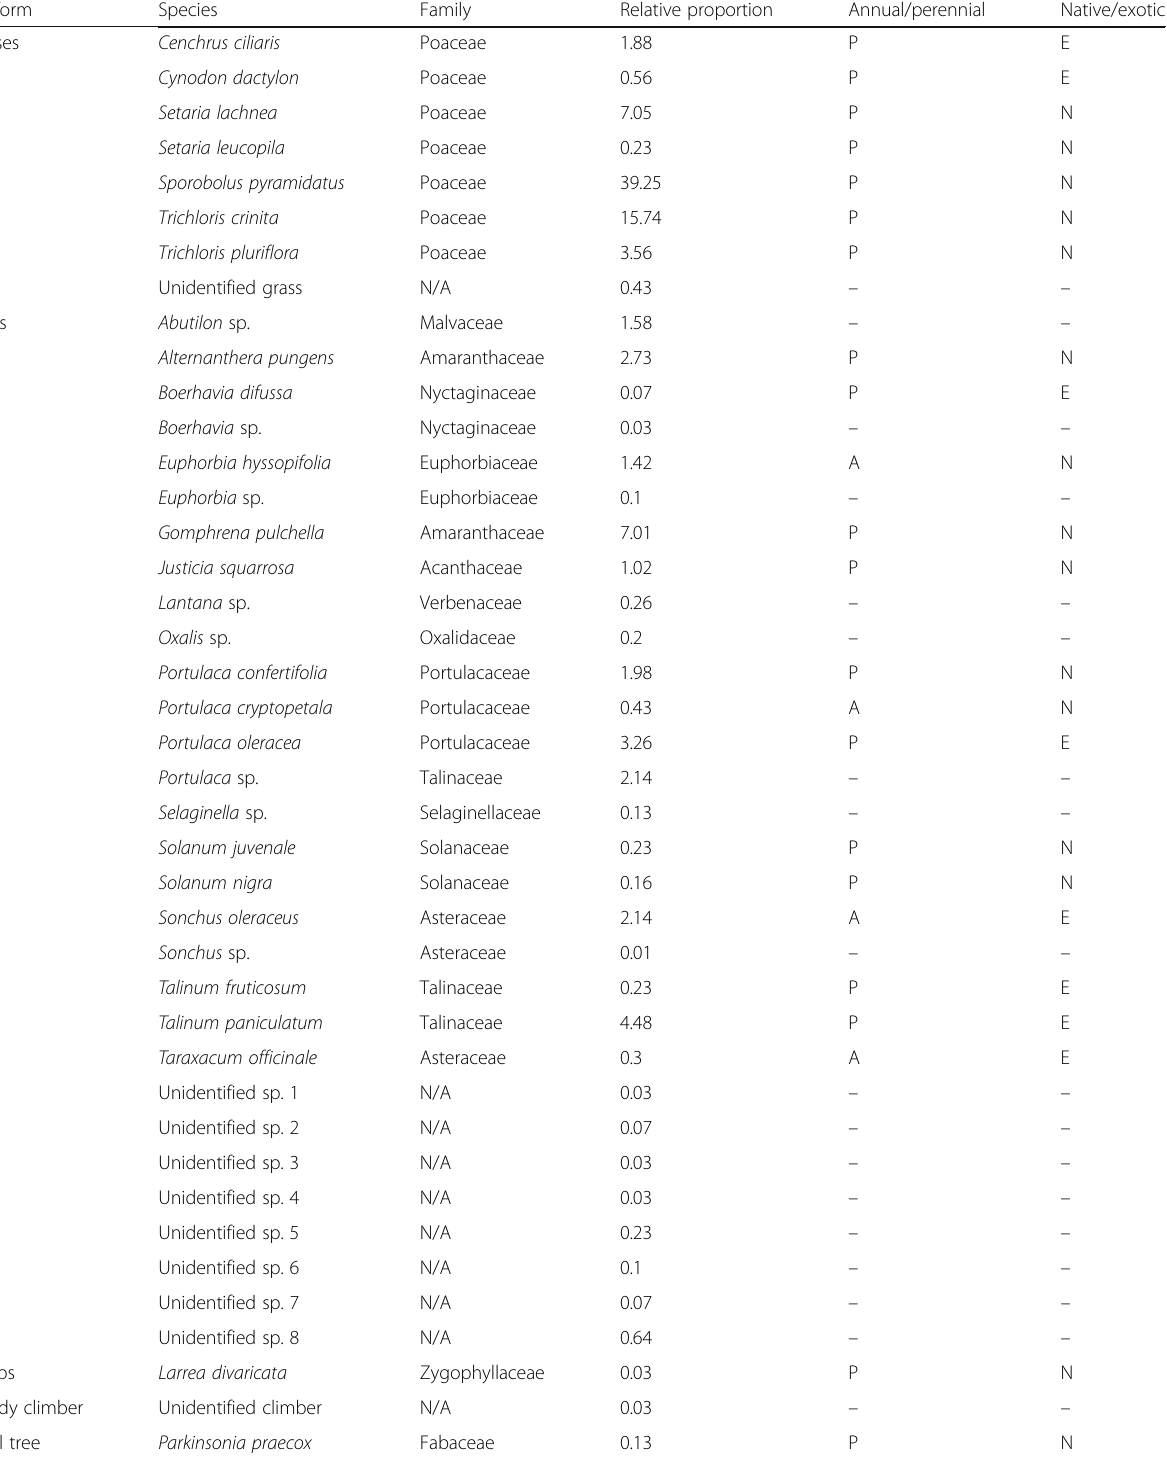
Table 2 Species or genera, family, and relative proportion of seedlings emerged from soil seedbank Life-form Species